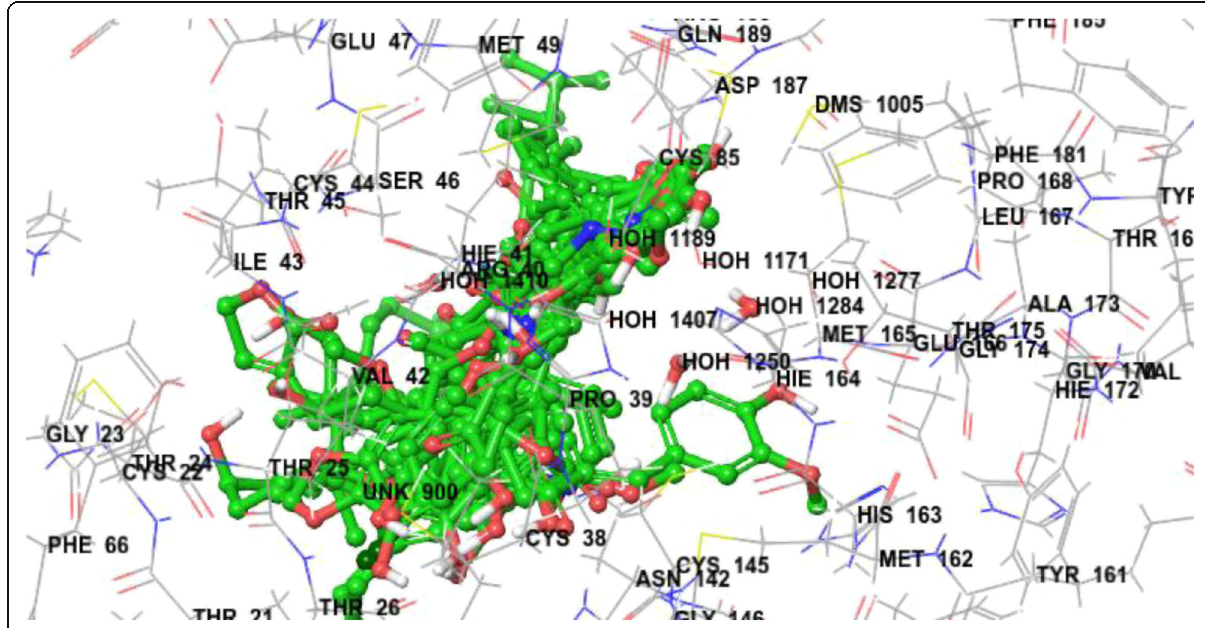
Fig. 2 Docked poses of all compounds with SARS CoV-2 main protease